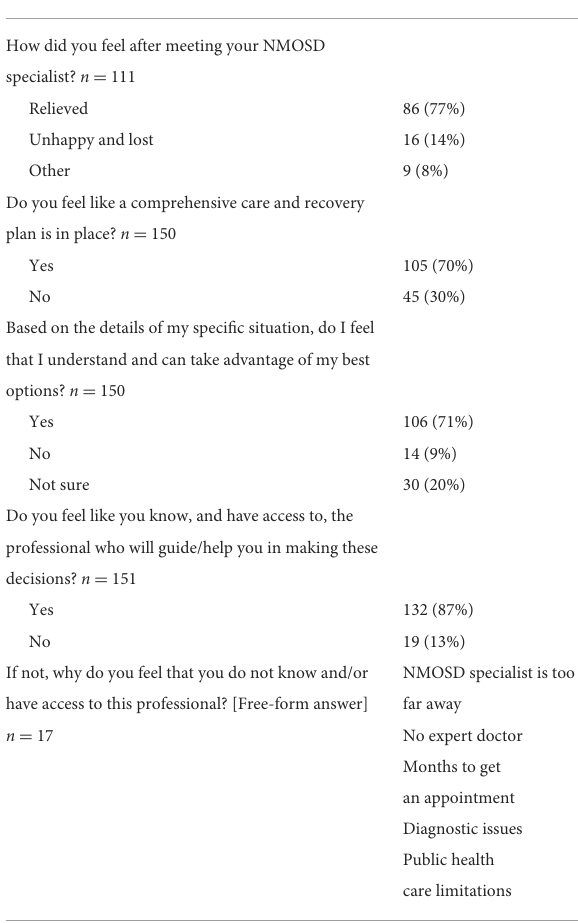
TABLE 5 Identification of treatment options after a definitive diagnosis. Question Responses, no.